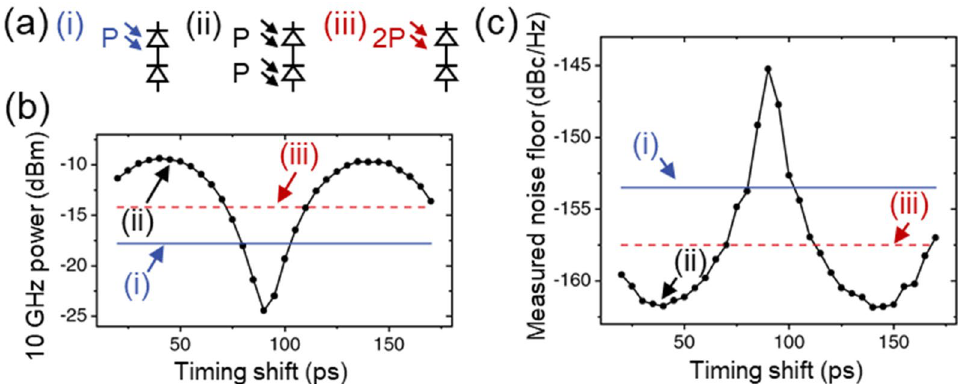
Figure 3. ( a ) Illumination conditions tested: (i) optical power (P, 2-mW) incident on single photodiode (top diode of BPD in this case), (ii) 2-mW incident on both photodiodes of opposite polarity with certain timing shift (Δt), (iii) 4-mW incident on single photodiode. ( b ) Microwave power at 10 GHz versus timing shift for each condition denoted in ( a ). ( c ) Measured noise floor for each condition denoted in ( a